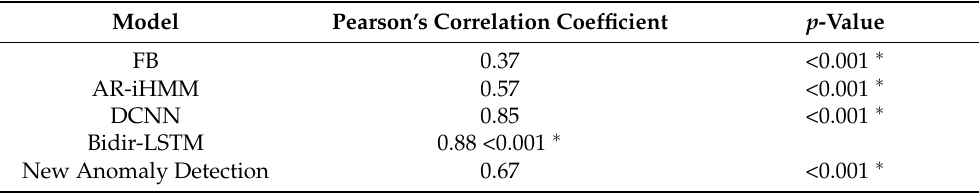
Figure 5. Association between the gold standard and the DCNN model output. Each point represents the sum of the activity for each day. ( a ) Pearson’s correlation coefficient = 0.83; p -value < 0.001. ( b ) OAs: Pearson’s correlation coefficient = 0.95; p -value < 0.001. When removing the outlier point in the upper right corner, the Pearson’s correlation coefficient changed to 0.9. Table 4. Correlation between the gold standard and the gait detection models in the PD cohort.